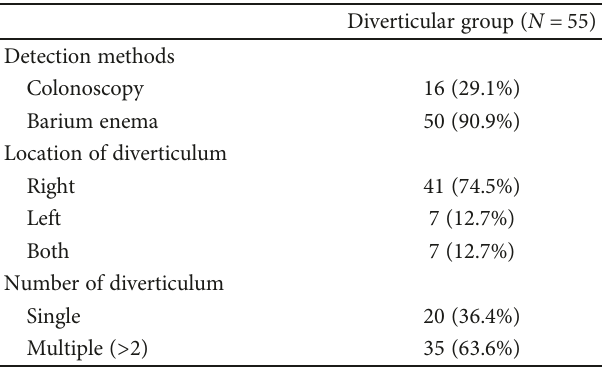
Table 2: Detection methods and characteristics of diverticular